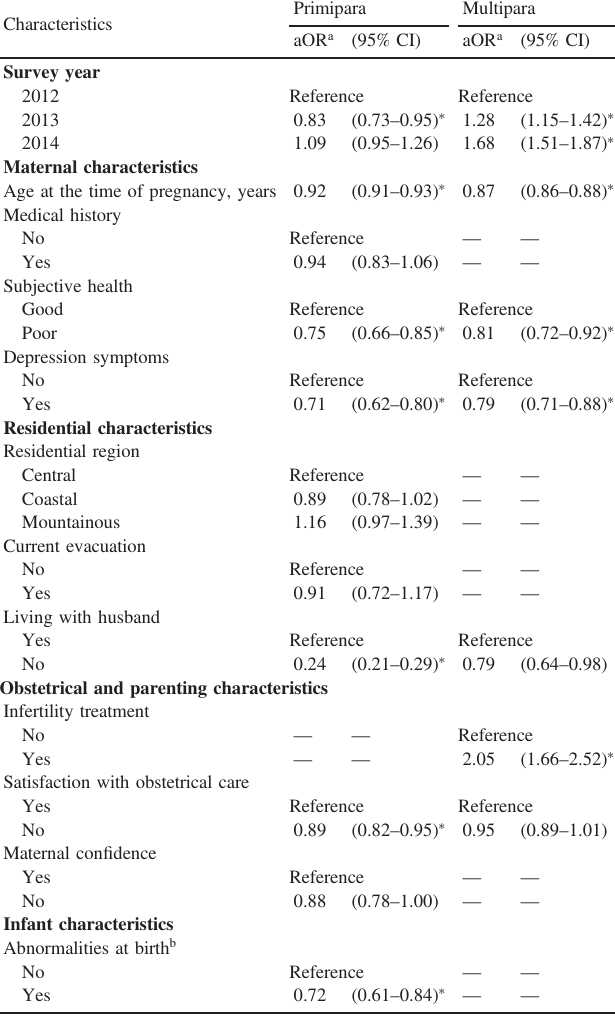
Table 2. Factors associated with mothers ’ pregnancy intention by parity